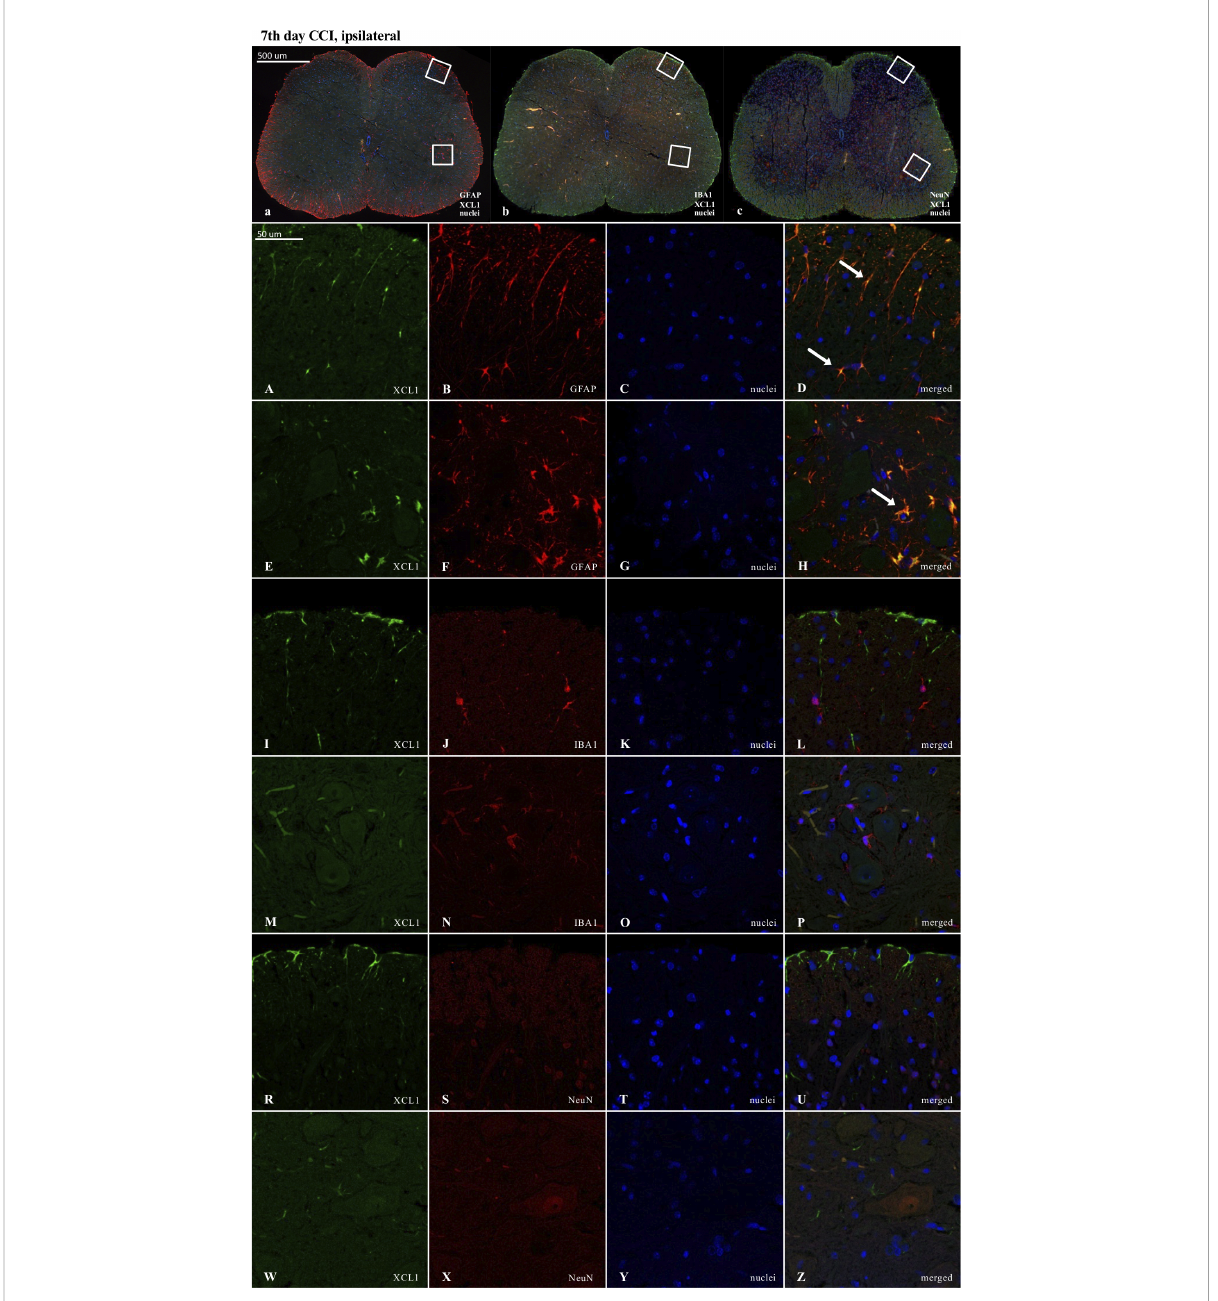
FIGURE 8 Immuno fl uorescence analysis of chemokine-C-motif ligand 1 (XCL1) localization in the lumbar (L4 to L6) spinal cord 7 days after chronic constriction injury (CCI) of the sciatic nerve in mice. Dorsal (A – D, I – L, R – U) and ventral (E – H, M – P, W – Z) parts of lumbar spinal cord ( a,b,c ) were shown as an approximate fragments of selected images. Representative immuno fl uorescence images from colocalization analysis performed on spinal cord, paraf fi n-embedded 7 m M microtome slices: XCL1 (green: A, E, I, M, R, W ) with astroglia marker glial fi brillary acidic protein; (GFAP, red: B, F ); microglia marker ionized calcium-binding adaptor molecule 1; (IBA1, red: J, N ); and with neuronal marker neuronal nucleus; (NeuN, red: S, X ), Nuclei are in blue ( C, G, K, O, T, Y ). High magni fi cation, three-dimensional image rendering shows XCL1 localization inside GFAP-positive cells (yellow: D, H ). Scale bars: 50 m m ( a, b, c ), 500 m m (A – Z)